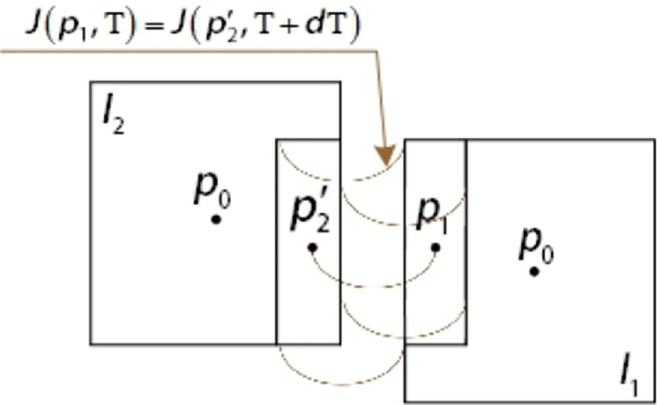
Fig 7. Schematic diagram of optical flow method between aerial camera swing scanning